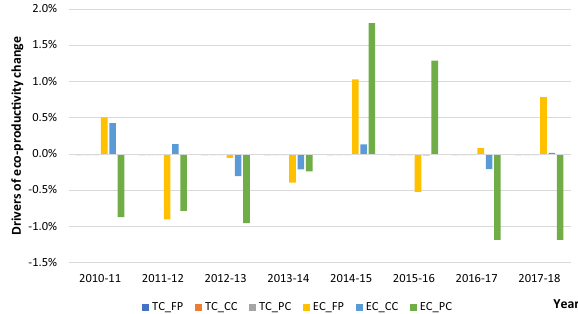
Fig. 4 Drivers of eco-productivity change of Chilean water companies. Average estimates of technical change (TC) and ef fi ciency change (EC) for eco-productivity change (eco-MPI) of Chilean water companies by